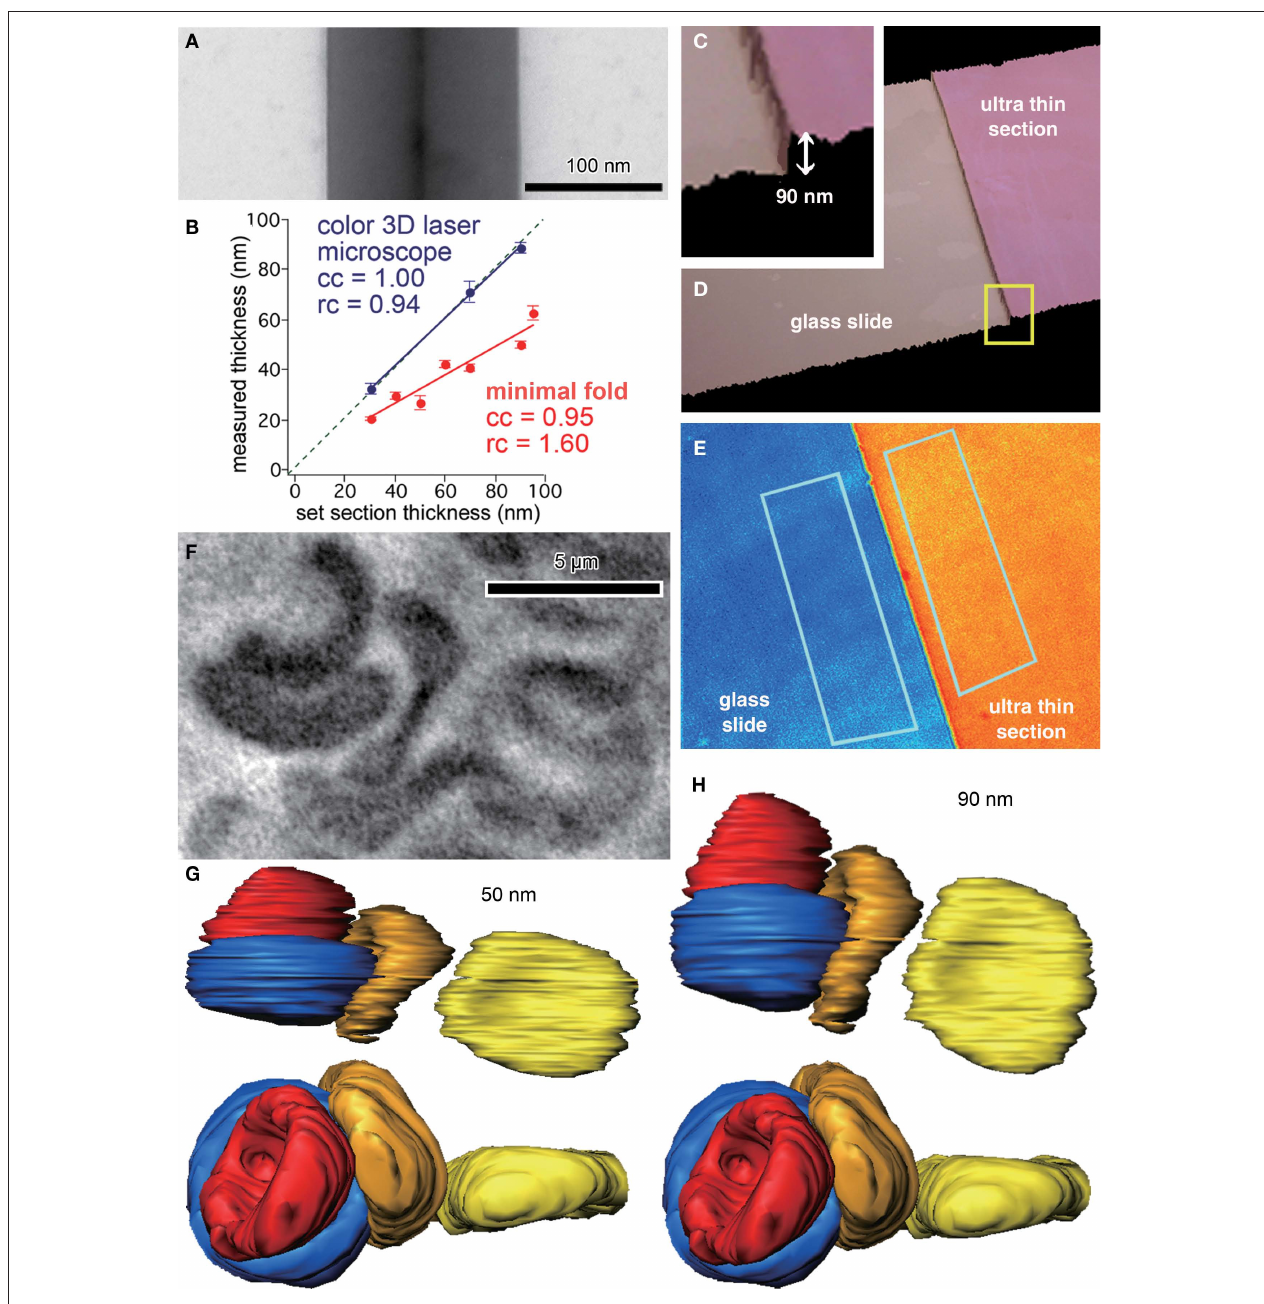
FIGURE 1 | Thickness estimation of ultrathin sections for 3D reconstruction. (A) Minimal folds of an ultrathin section cut by a microtome set to cut 95 nm sections. Width of the minimal folds, twice the section thickness, was 130 nm, much less than expected. Note the black vertical line at the center of the fold, which is the adhered, folded membrane perpendicular to the plane of a section. (B) Correlation between section thicknesses set by the microtome and those measured by a color laser 3D microscope or the minimal folds method. The thicknesses measured by the optical method were more similar to those set by the microtome than those measured by the minimal folds method, which were 50–80% of the set section thickness. (C, D) Three- dimensional view of ultrathin section (90 nm thickness, pink) on glass slide (beige) obtained by the laser scanning microscope. The border of the section and slide surface is clearly identifi ed in larger magnifi cation (C) . (E)